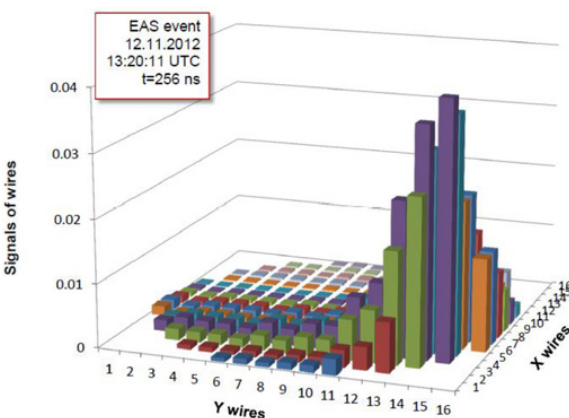
Figure 11. The particular distribution of the Cherenkov signal outputs on the surface of the photo-anode. A grid of wires has a pitch size of 3.75 mm. The distribution is taken at the time t = 256ns after the event trigger when the signal amplitudes are approximately